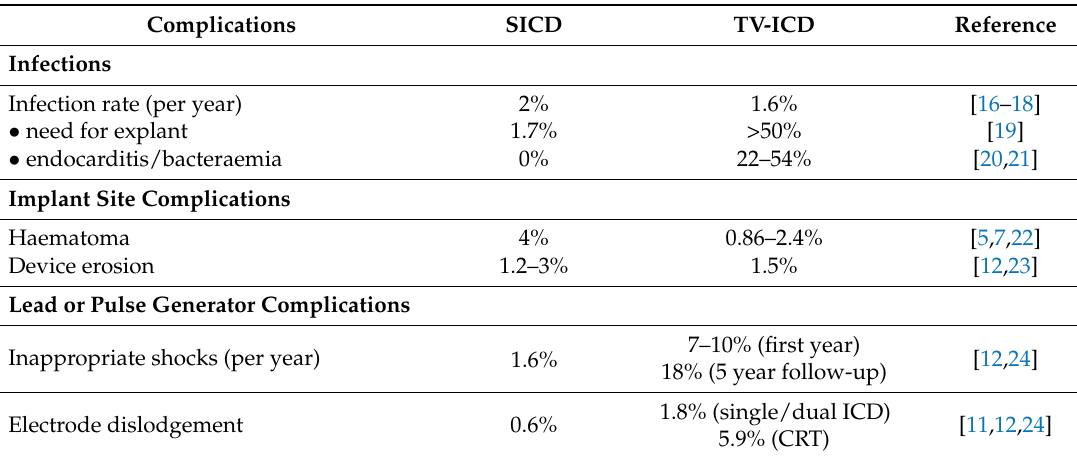
Table 2. Comparison of S-ICD and TV-ICD